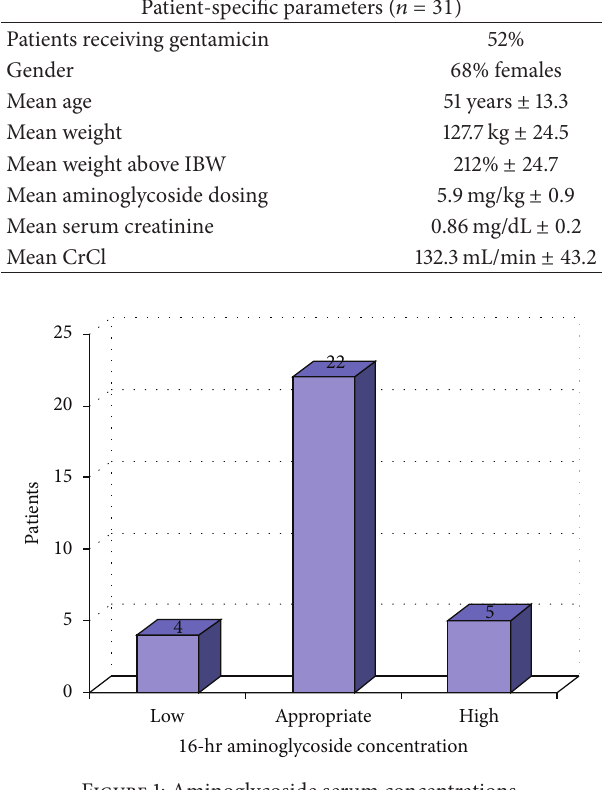
Figure 1: Aminoglycoside serum concentrations.